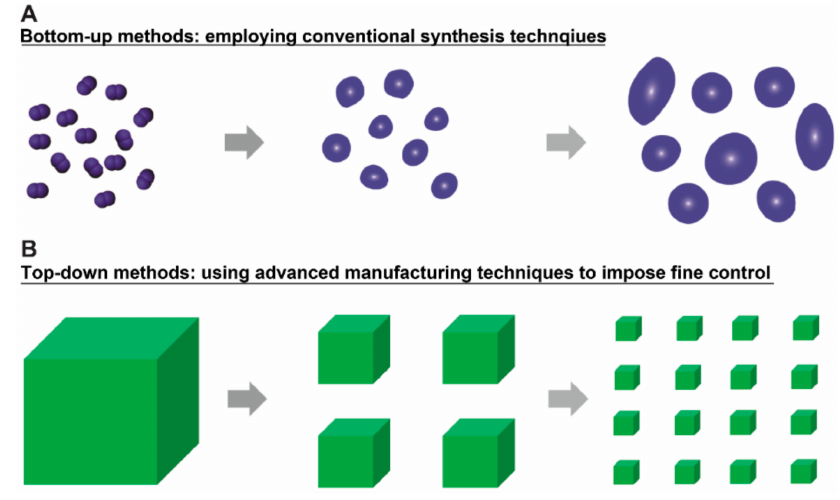
Figure 1. The existing micro/nanoparticle production techniques can be classified into two methods: ( A ) Bottom-up methods. The bottom-up methods employ conventional synthesis techniques (i.e., emulsion) to generate micro/nanoparticles with several shapes, including spherical, rod, etc. The particles usually vary in sizes and are not controllable in other properties such as cargo loading; ( B ) Top-down methods. This group of methods relies on using advanced manufacturing techniques to impose fine spatial control over the materials. Due to this spatial control, the micro/nanoparticles from these methods have well-controlled size, shape, surface property and component materials. This review focused on introducing micro/nanoparticles produced by advanced manufacturing techniques and discussing the applications of these micro/nanoparticles in delivering therapeutic